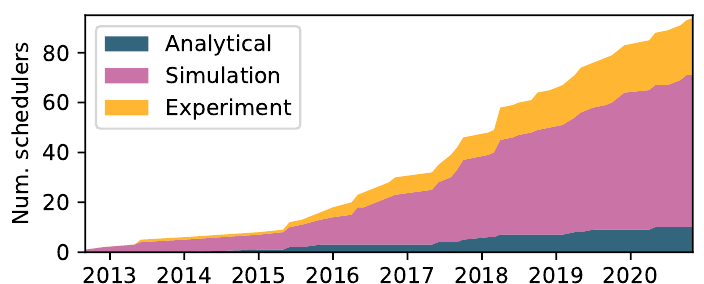
Figure 8. Cumulative distribution of schedulers per evaluation method.